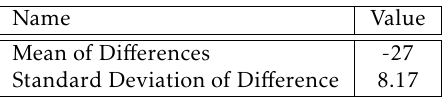
Table 3. Statistical Values of Obtained Results